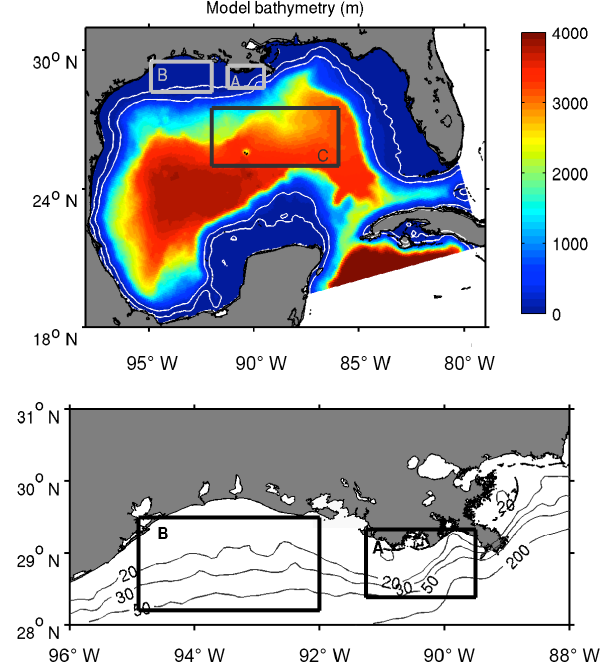
Figure 1. Model domain and bathymetry. Polygons A, B, and C de- pict the MS delta, Texas shelf, and deep-ocean region, respectively, selected to describe plankton patterns. Gray contours show the 20, 30, 50, and 200m isobaths.